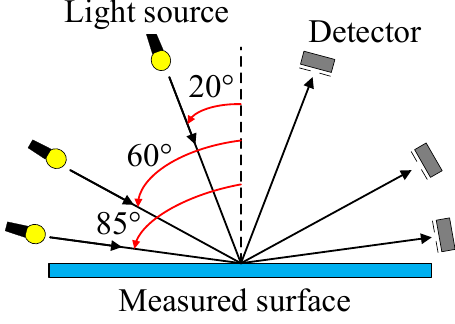
Figure 1. The test method for glossiness.